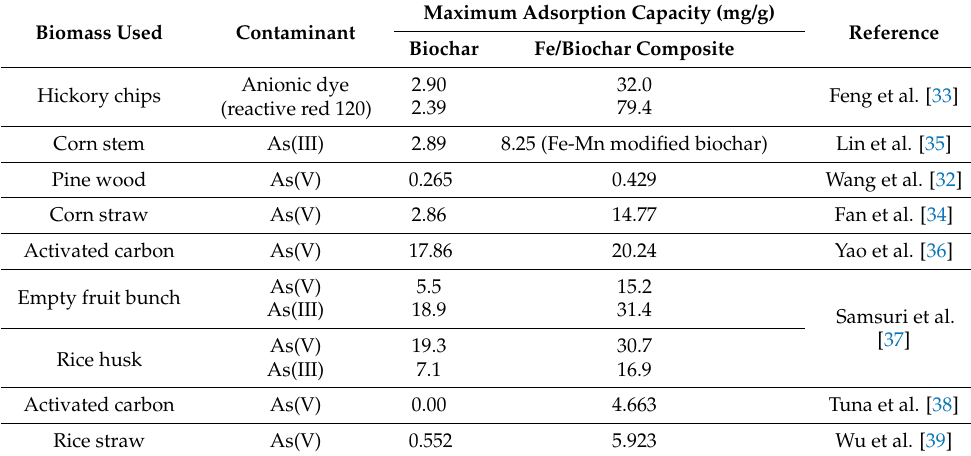
Table 2. Changes in adsorption capacity for anionic contaminants before and after Fe modification for various biomass-based